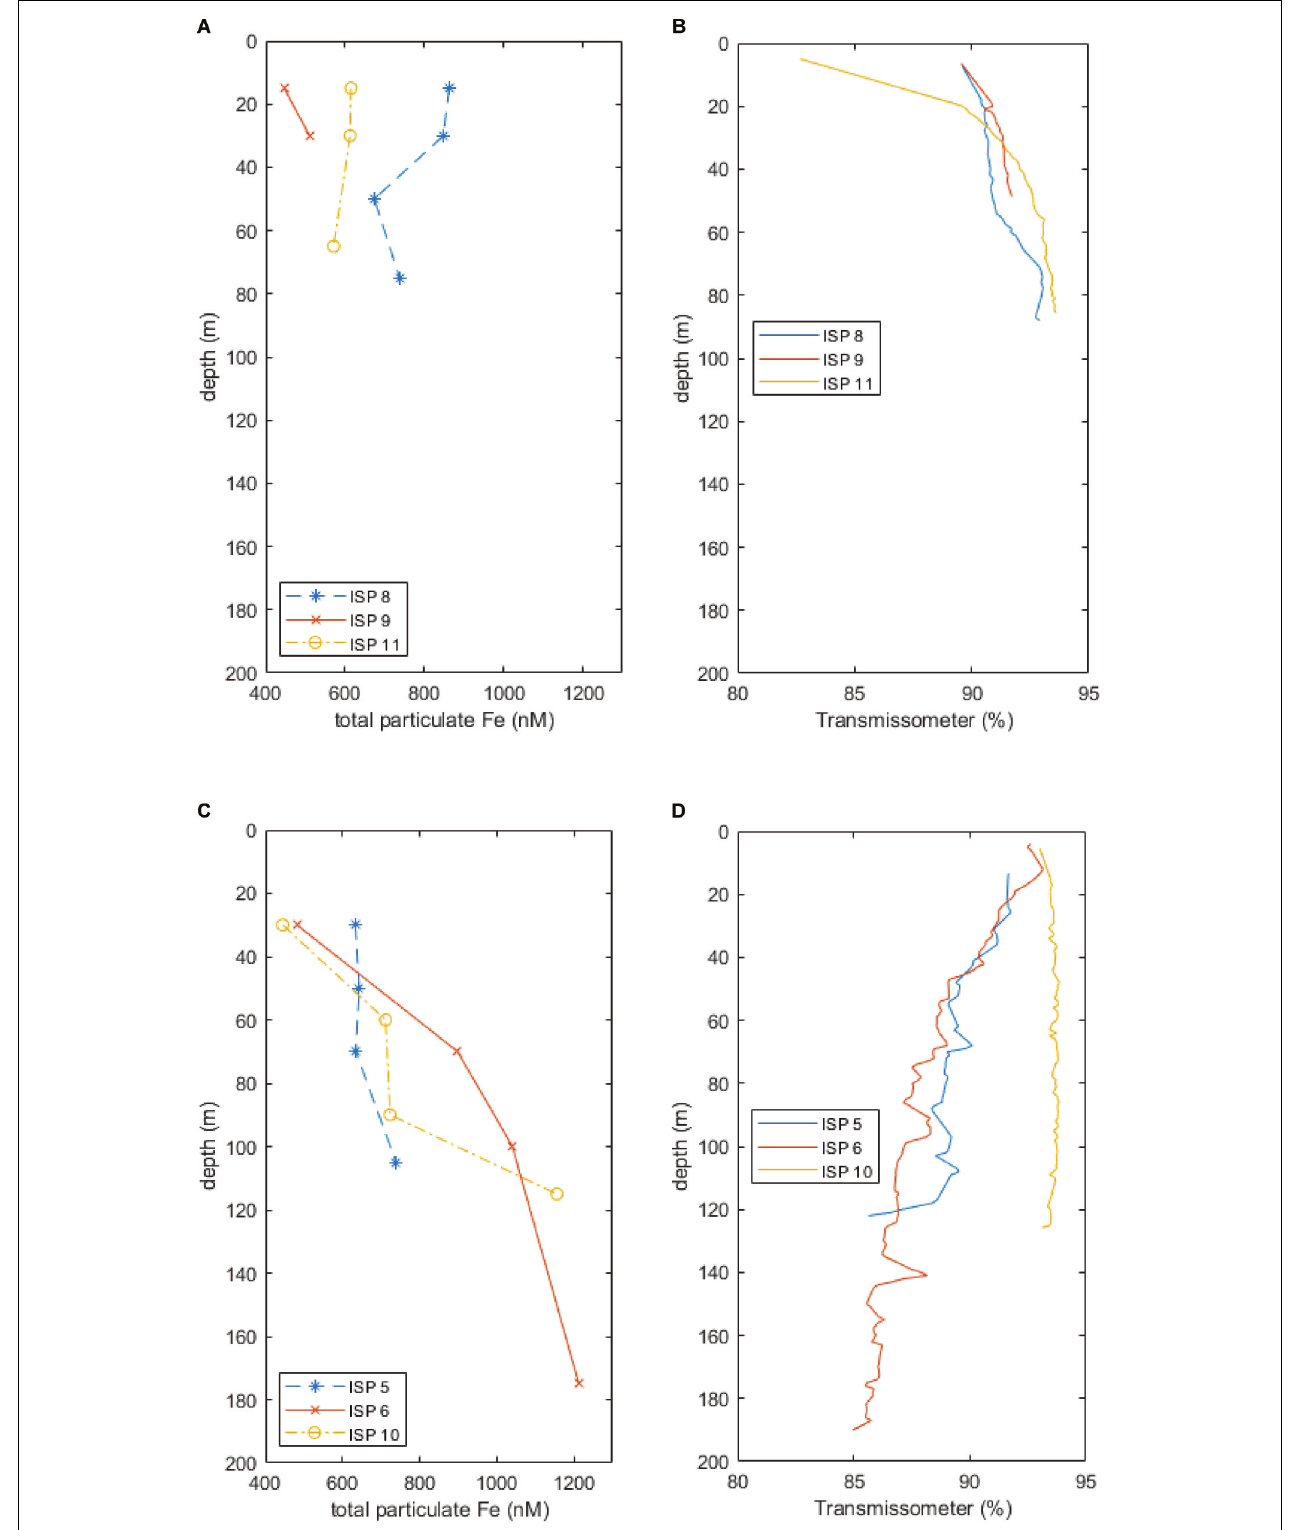
FIGURE 10 | Total particulate Fe (labile + refractory) plotted alongside transmissometer data at Heard ( A,B , respectively) and McDonald ( C,D , respectively) Islands. Lower light transmittance implies more suspended material in the water column. Note the contrasting trends of increasing pFe and suspended particles with depth at McDonald Island versus generally decreasing pFe and suspended particles with depth at Heard